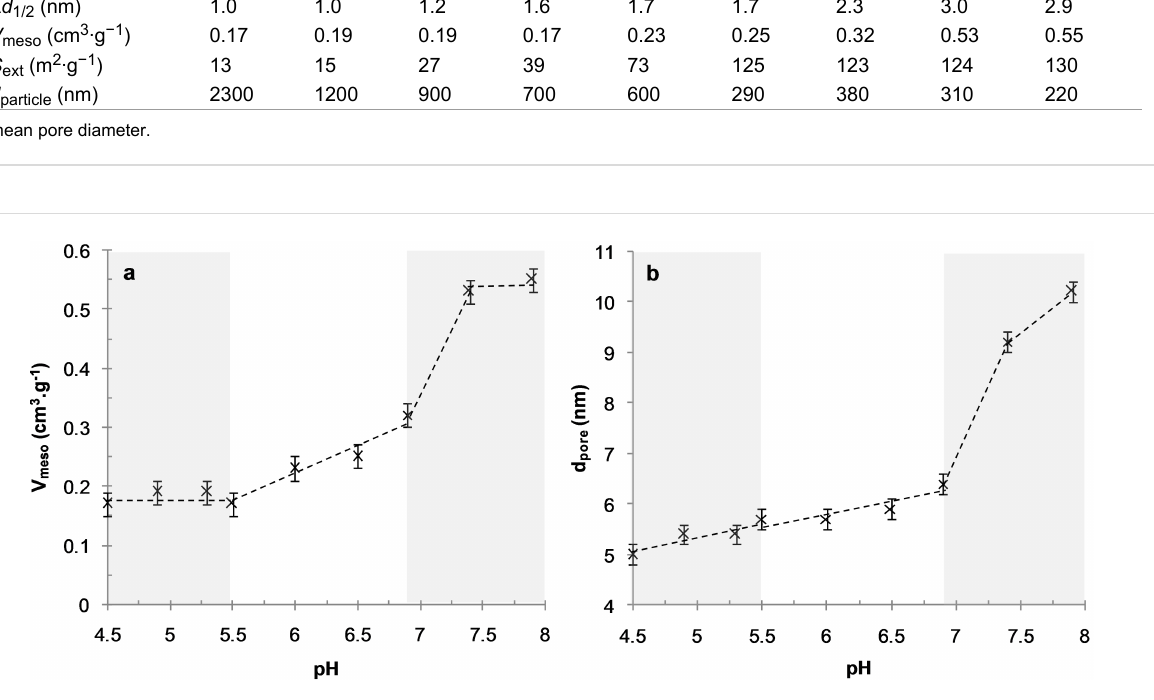
Figure 3: Mesopore volume (a) and pore diameter (b) of the calcined materials synthesized at 3.9 wt % DHBC at various values of